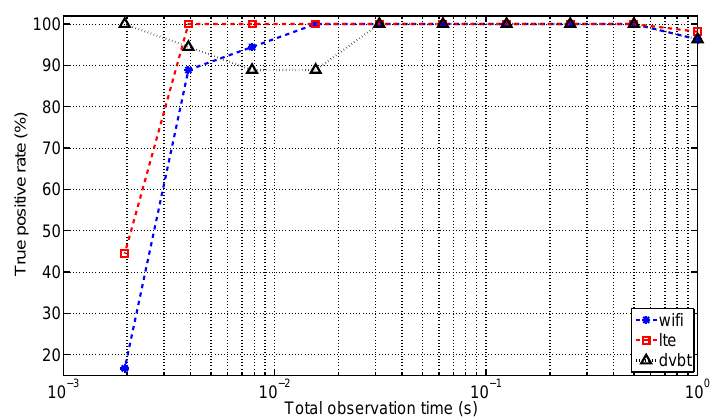
Figure 12. The true positive rate versus the total observation time, for N =